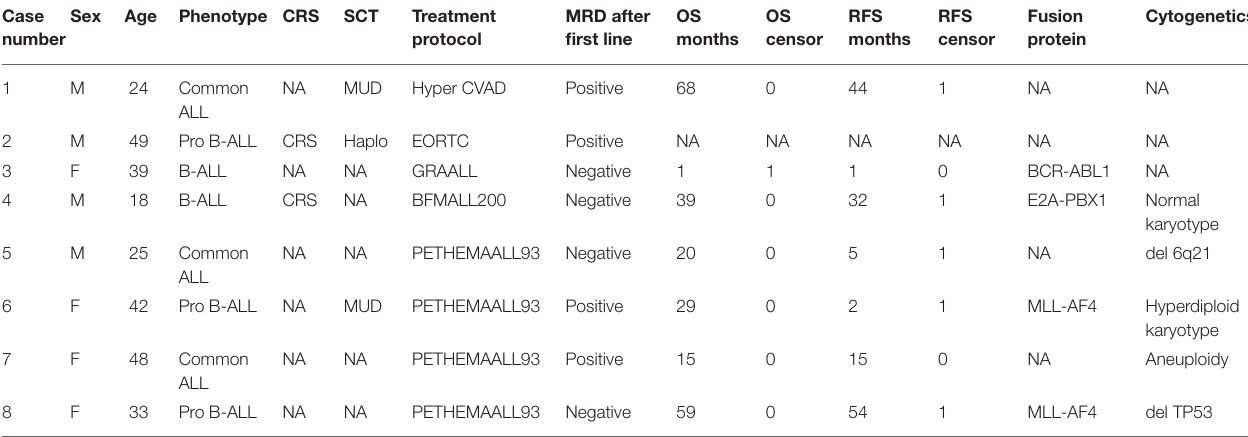
TABLE 1 | Romanian experience with the use of blinatumomab for B-cell ALL until May